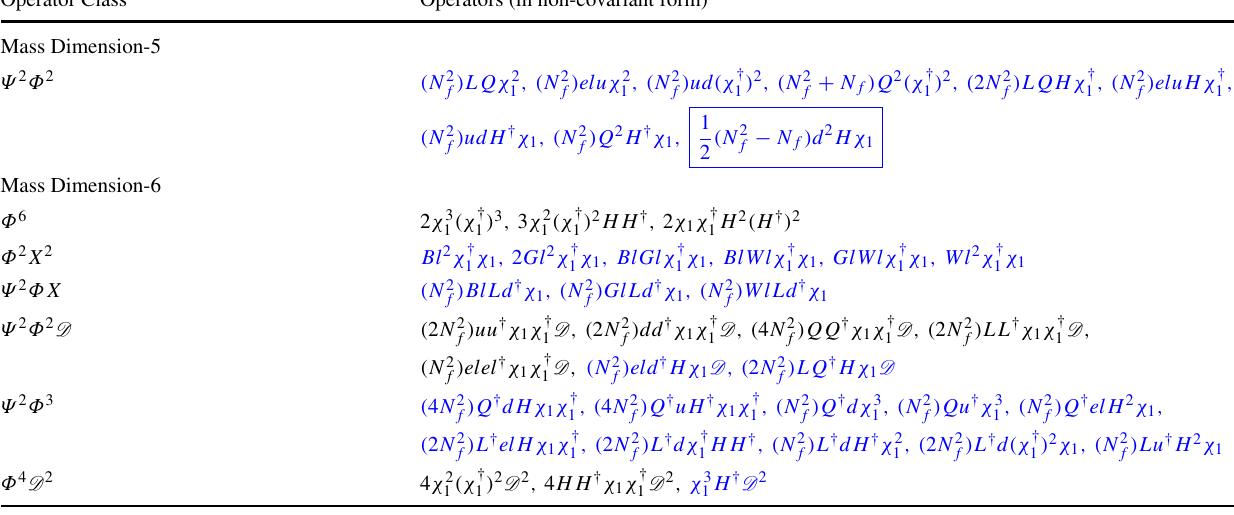
Table 39 Lepto-Quark Model 1( χ 1 ): Operators of mass dimensions-5 and -6 excluding pure SM operators Operator Class